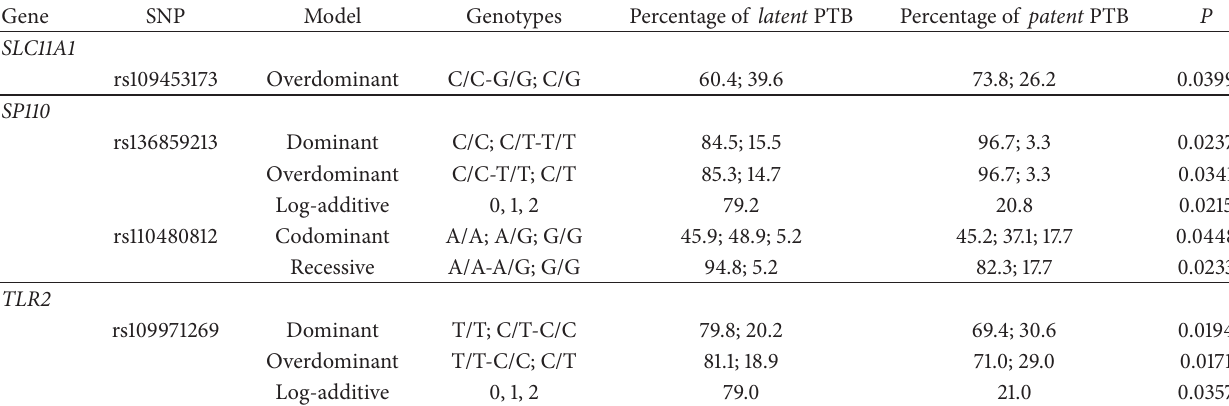
Table 4: Association results from latent PTB versus patent PTB logistic regression